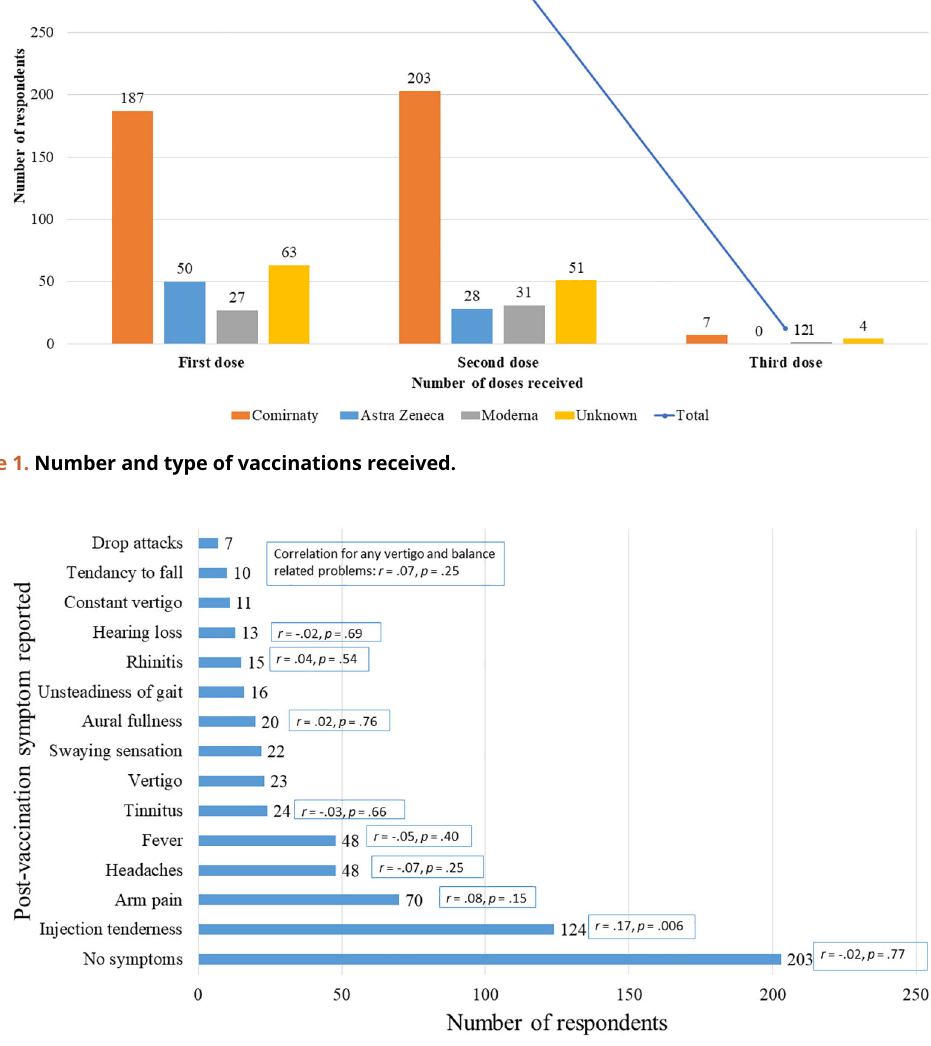
Figure 2. The presence of post-vaccination adverse effects. Correlation coefficients provided represent Spearman ’ s correlations between the symptom and type of vaccination